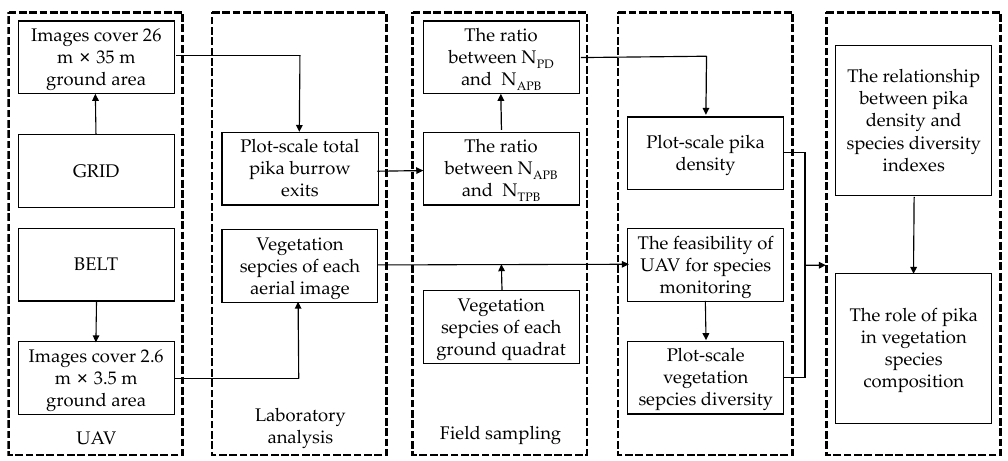
Figure 2. The flowchart of study scheme. N APB , N TPB and N PD mean the number of active pika burrows, total pika burrows and pika density in a hectare, respectively.